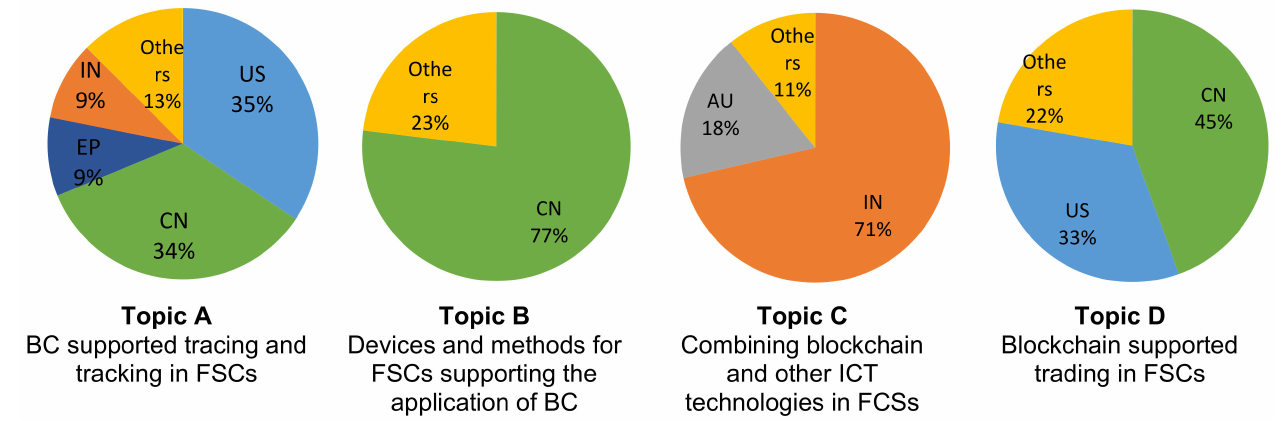
Figure 8. Distribution of patents within topics by country of